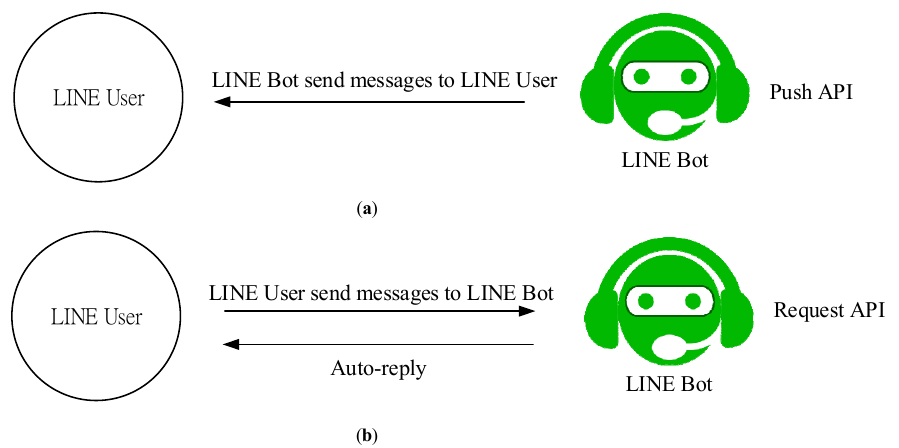
Figure 15. Messaging API flowchart.